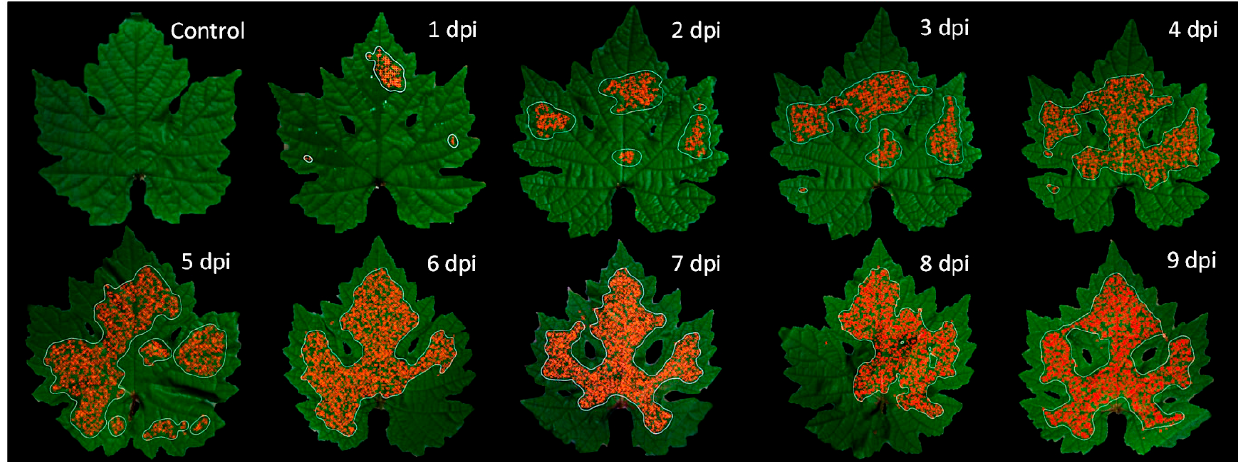
Figure 6. Spatial distribution of downy mildew strain INRA-Pv45 over a grapevine leaf from 1 to 9 dpi, automatically detected by the SVM classifier. The leaf remained unknown to the classifier, as a test set. Positive patches of downy mildew are represented by red crosses. The downy mildew was slightly detected at 1 dpi, then three zones of infection were clearly detected at 2 dpi, corresponding to the three drops of inoculum deposited on the leaf on day 0. The infected area grew over time and covered almost the entire leaf at 9 dpi, except leaf borders which were not considered in the detec- tion.